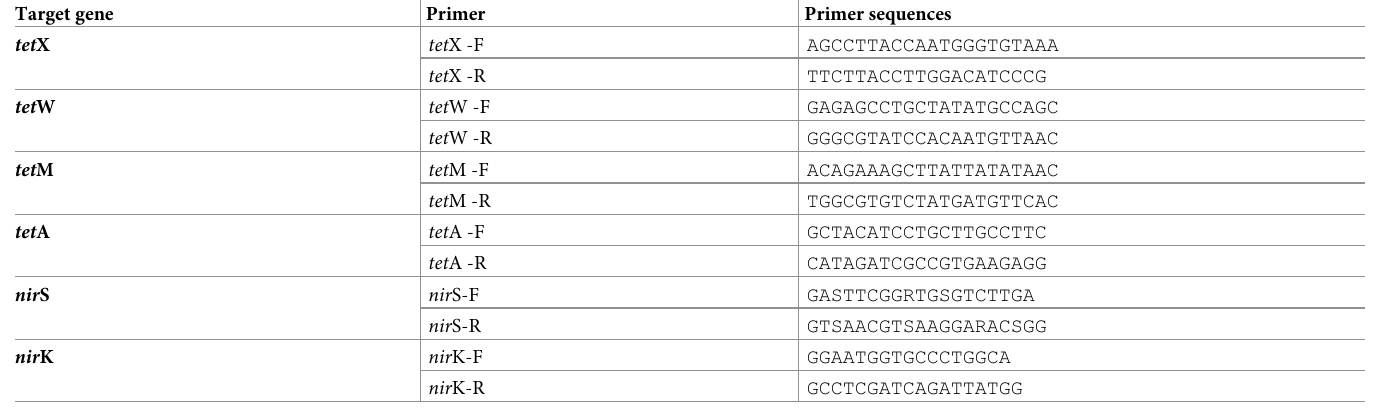
Table 1. PCR primers of the tetracycline resistance genes and denitrification functional genes. Target